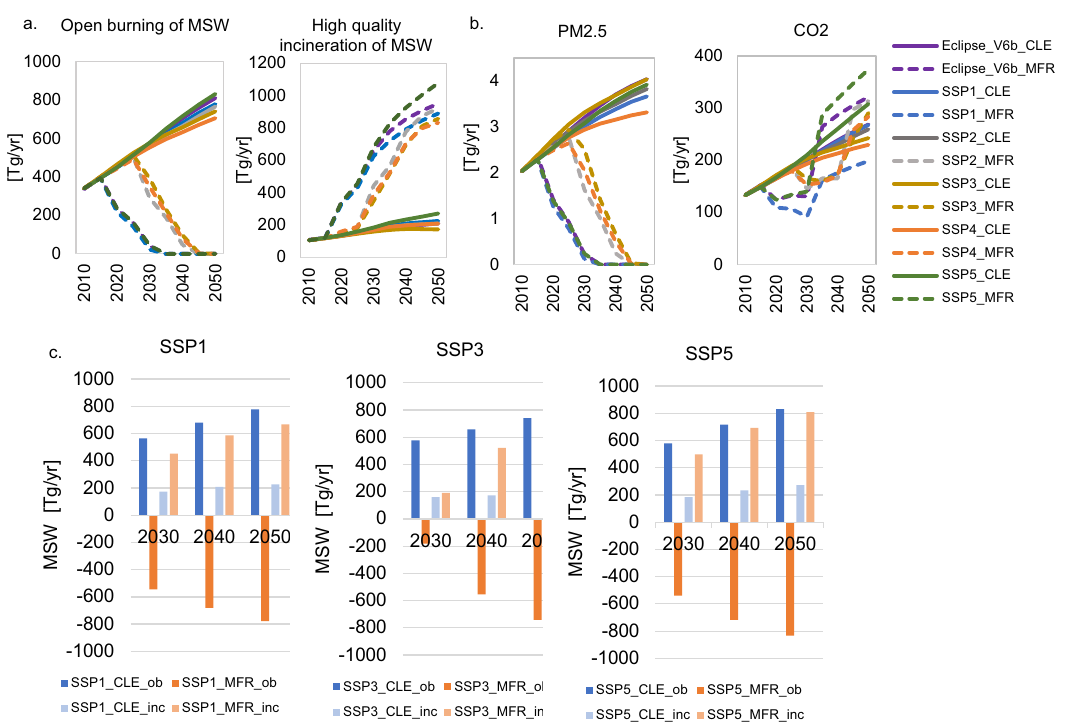
Fig. 5 Global municipal solid waste incinerated and burned in open fi res and related emissions. a Global amounts of municipal (MSW) incinerated and burned in open fi res, b related emissions under baseline (CLE) and mitigation (MFR) scenarios and c MSW burned in open fi res and incinerated (negative values in y -axis refer to the avoided open burning of MSW). Reduction fractions of MSW open burned result in the same reduction percentage of particulate matter and air pollutants. An increase of MSW incinerated with energy recovery is expected in all MFR scenarios. The reduction of CO 2 emissions results from the decline of MSW openly burned and increase of recycling. Growth in CO 2 emissions in the MFRs families after 2030 is driven by the increase of MSW generation and the diversion of refuse MSW from land fi lls to incineration with energy recovery. The additional decline in CO 2 emissions in the SSP1_MFR is the consequence of reducing plastic waste generation. Supplementary Information section 2 presents a detailed analysis of the MFR